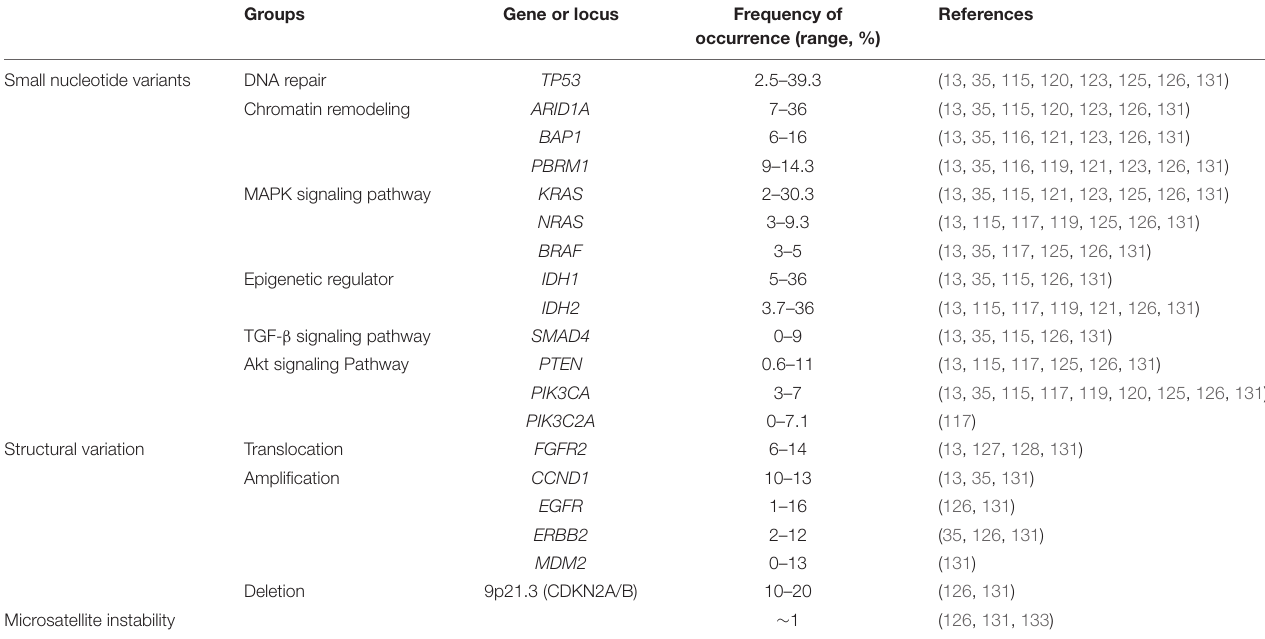
TABLE 2 | Major somatic variants and reported incidence in intrahepatic